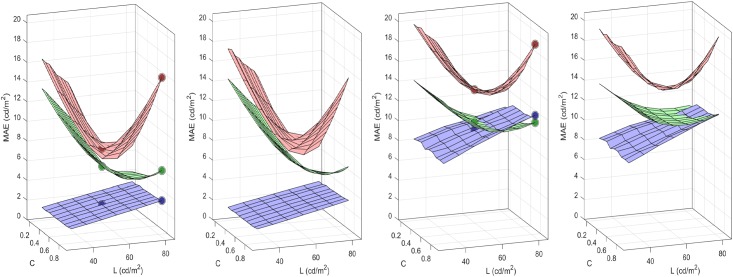
Decoding error.Left panels show the Mean Absolute Error (MAE) in the low-distortion regime and panels of the right show the MAE in the high-distortion regime. Image luminance is in the range [0, 160] cd/m2. In each case surfaces red, green and blue represent the error of the linear regression, non-linear regression and analytic decoders. In each distortion regime, the panel at the left shows the results of the decoders trained for that regime. The panel of the right represents the case where the signal is reconstructed by decoders trained in a different distortion regime. The highlighted points correspond to the error of the decoded images shown in Figs 14 and 15. Note that the points at the center correspond to the optimum for the learning-based decoders: the training illumination and distortion. Axis label, L means Luminance, and C means Contrast.